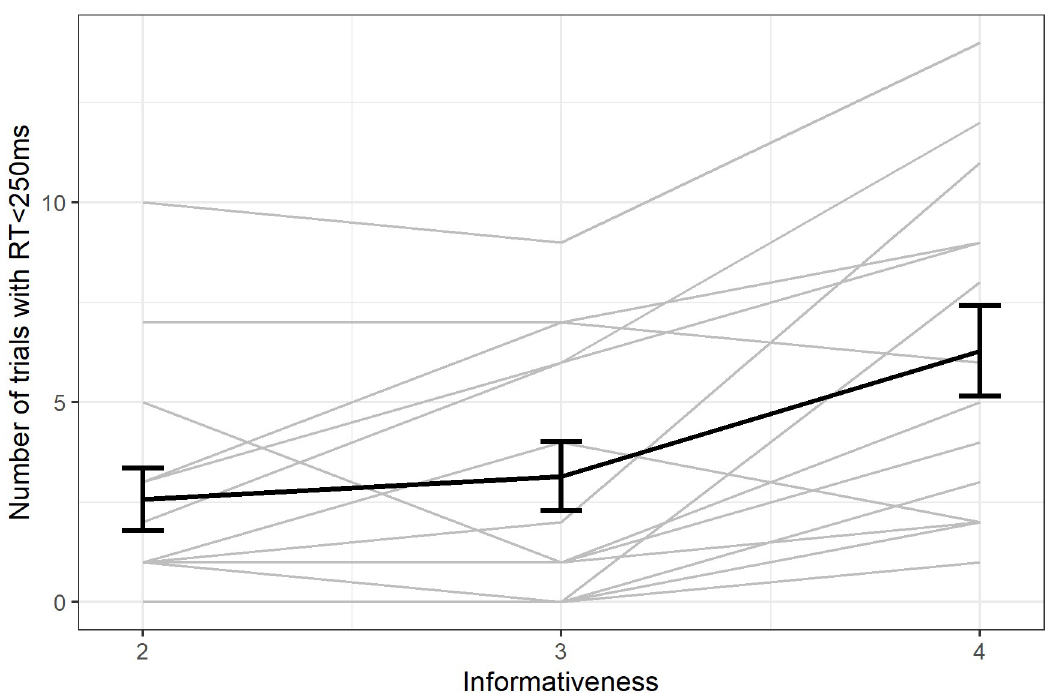
Fig 8. Number of correct revealed trials with RT < 250ms. Individual responses (light grey) with group average (error bars represent standard error).